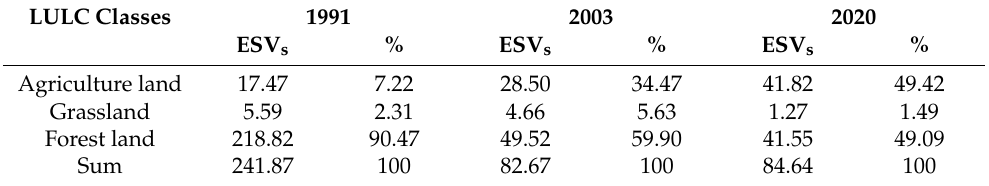
Table 6. The LULC variation on the ESVs (10 6 US $ at 2020 price levels) in the Matenchose watershed. LULC Classes